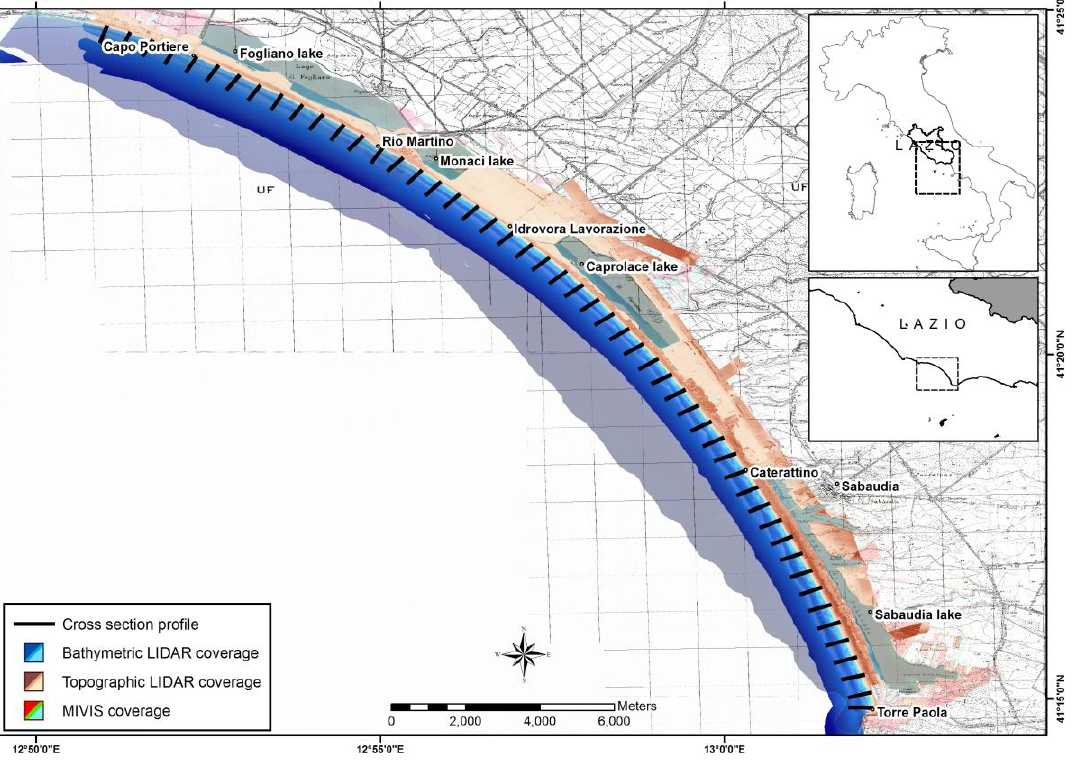
Figure 1. Sabaudia study area along the Lazio Region (Tyrrhenian Sea, Italy). The figure shows: Topographic and Bathymetric LiDAR data, MIVIS coverage and cross section profiles (500 m spaced) used for the analysis.